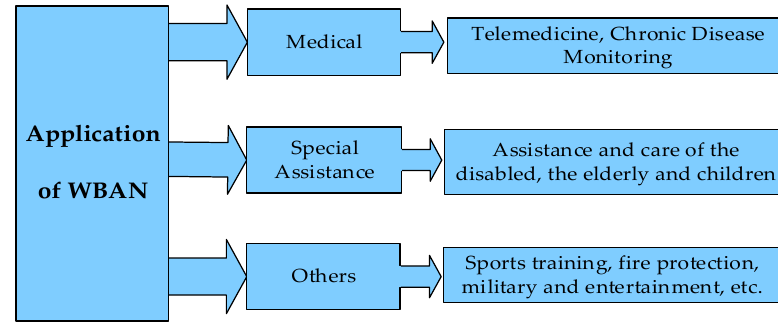
Figure 2. Applications of WBAN.